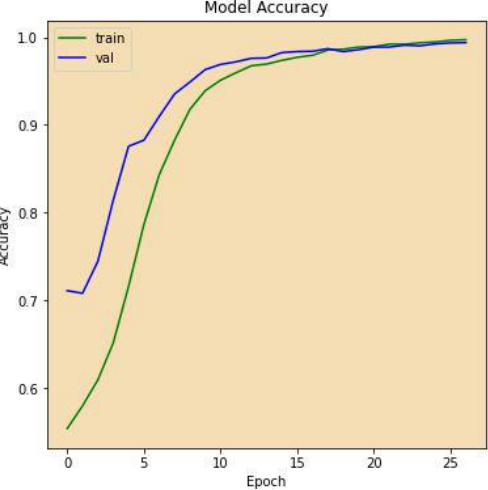
Figure 9. Model accuracy after using cGAN.